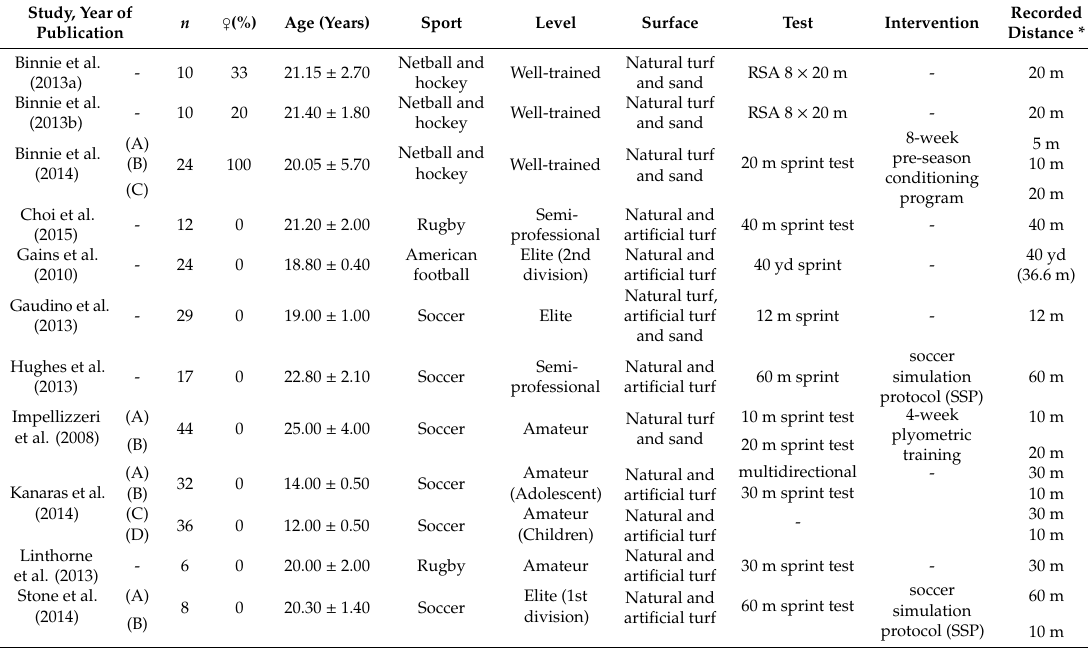
Table 1. Main characteristics of the studies included in the